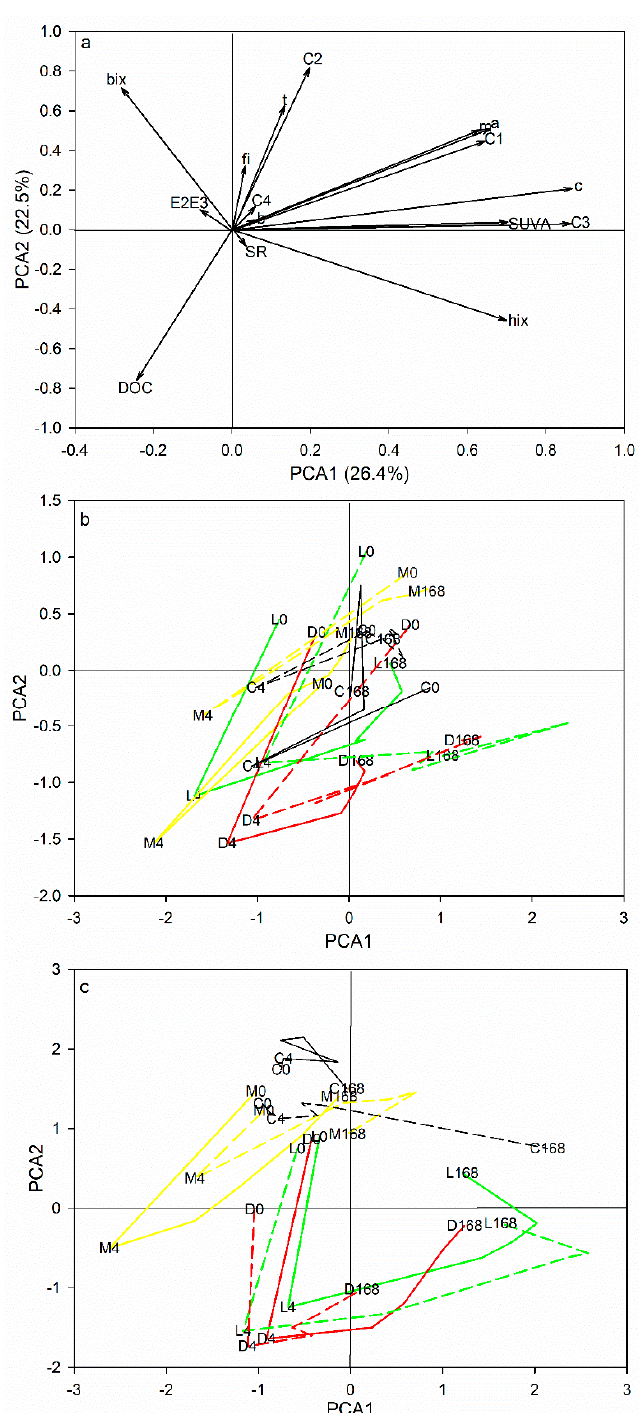
Figure 3. Principal component analysis (PCA) scores plot ( a ) and loadings plots for run 1 ( b ) and run 2 ( c ) for DOC concentrations and spectroscopic parameters. Points represent replicate means ( n = 3) for each source, day, and light treatment; colors represent sources (green = leaf, yellow = maize, red = dung), line styles represent light conditions (solid = light, dotted = dark), letters represent source and day (L = leaf, M = maize, D = dung; times: 0 (before) and 4 and 168 h after the addition).